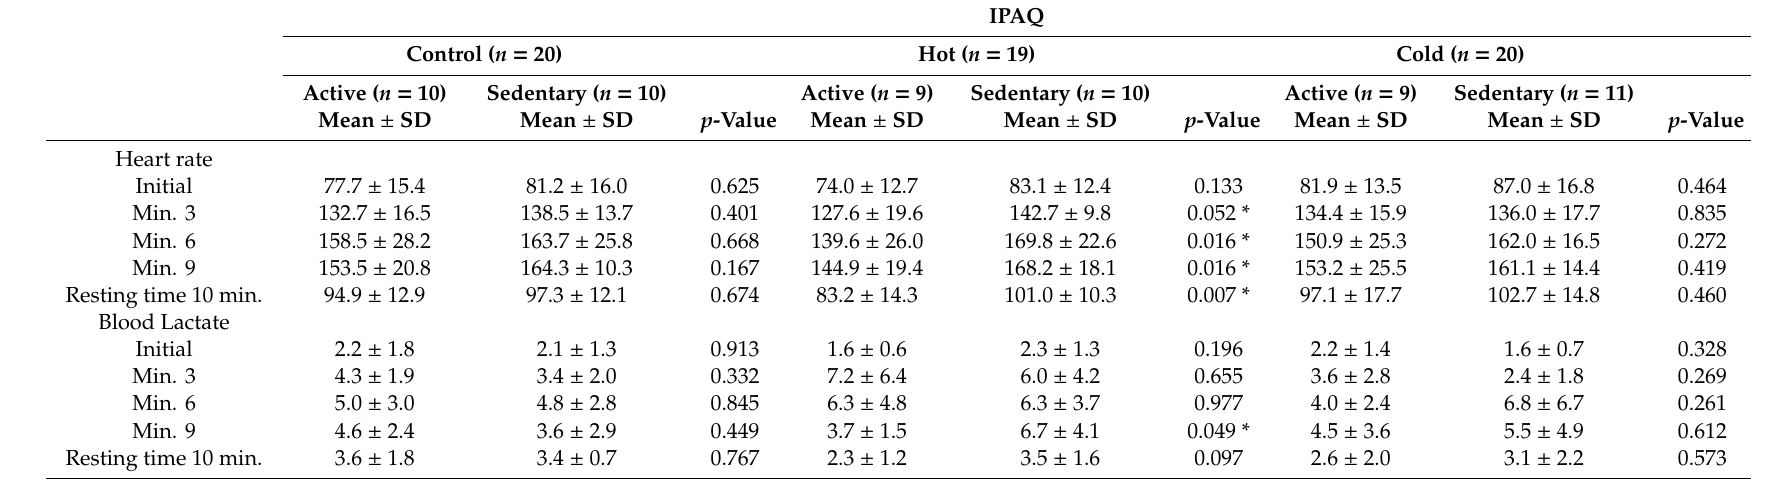
* Statistically significant di ff erences. SD, standard